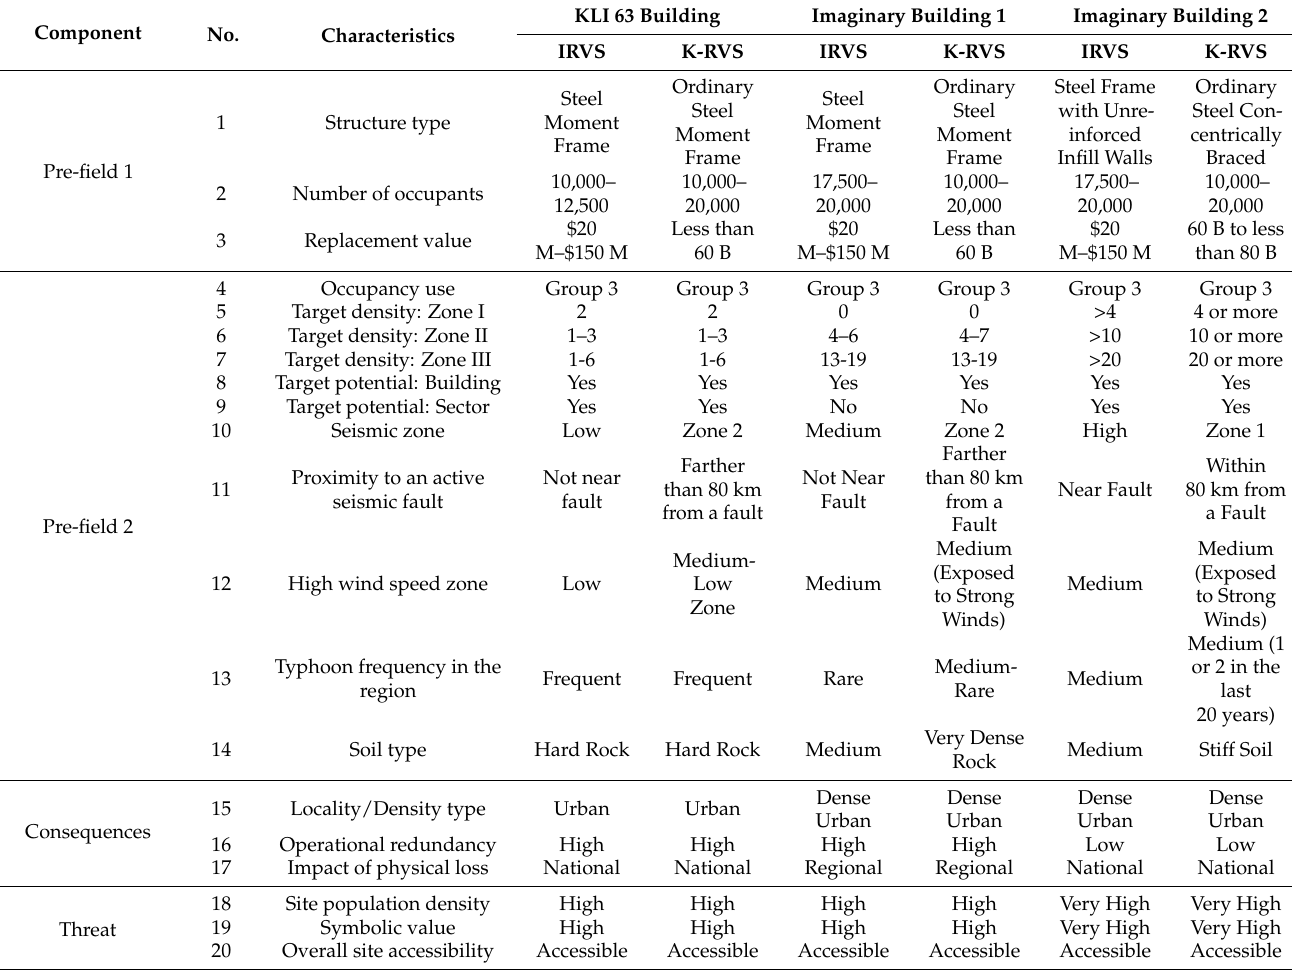
Table 11. Information on the KLI 63 building and two imaginary buildings in IRVS and